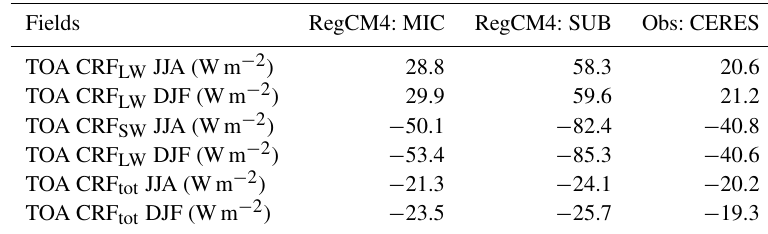
Figure 8. Simulated 10-year mean net TOA CRF for DJF (left panels) and JJA (right panels) by SUB and MIC and CERES observations. Grey areas indicate missing values. Table 4. Global means of MIC and SUB radiation fields vs.